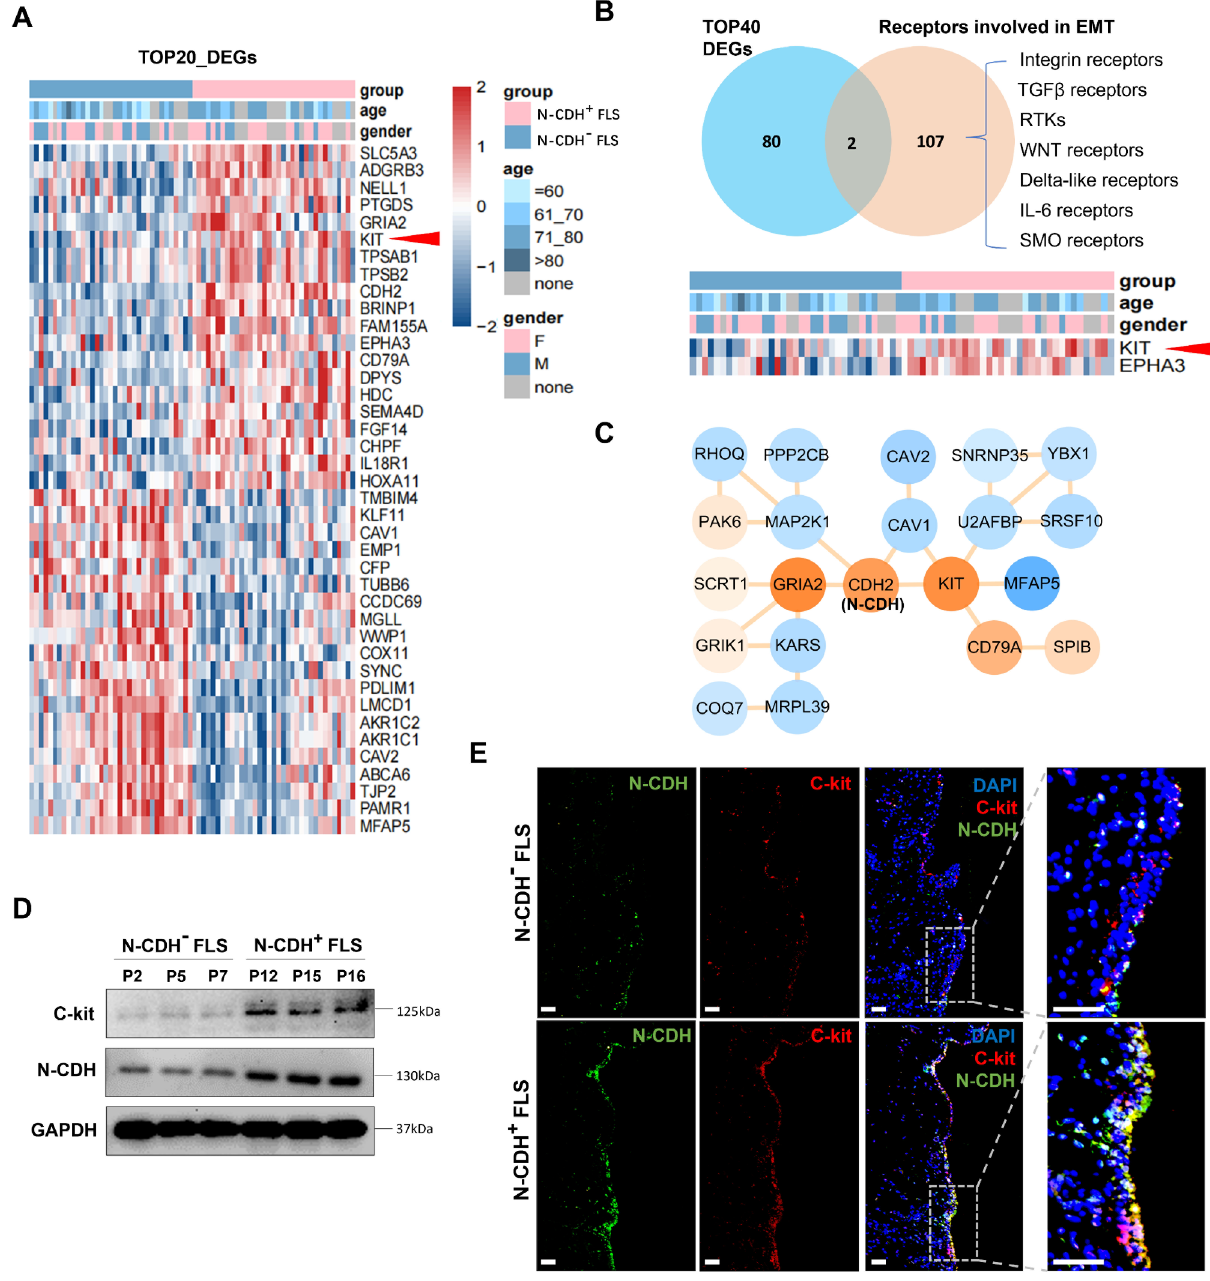
Fig. 2 N-CDH + FLS induces chondrocyte degeneration by paracrine (A) Assessment of EMT markers in the FLSs derived from different patients with N-CDH − and N-CDH + OA by Western blot (n = 3). (B) Illustration of co- culture of OA-FLS and chondrocytes. (C-D) Expression of OA chondrocyte inflammation and degradation mechanism genes (MMP1, MMP3, MMP13, and COMP) after co-culture with N-CDH − or N-CDH + FLSs for 0, 1, 3, and 5 days or not. (n = 3, bar = 100 μm). (E-F) After co-culture for 7 days, assessment of cell hypertrophy (E, bar = 100 μm) and collagen synthesis ability (F) of the chondrocytes. ∗ p < 0.05; ∗∗ p < 0.01; ∗∗∗ p <